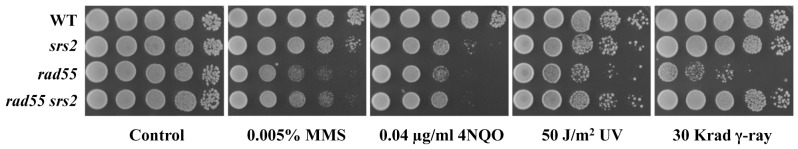
Genetic interactions between srs2 and rad55 in response to different types of DNA damage.A serial dilution assay with different treatments shows that srs2 completely suppresses rad55 ionizing radiation (IR) sensitivity but barely suppresses the sensitivity to other treatments. Experimental conditions were as described in Figure 1.